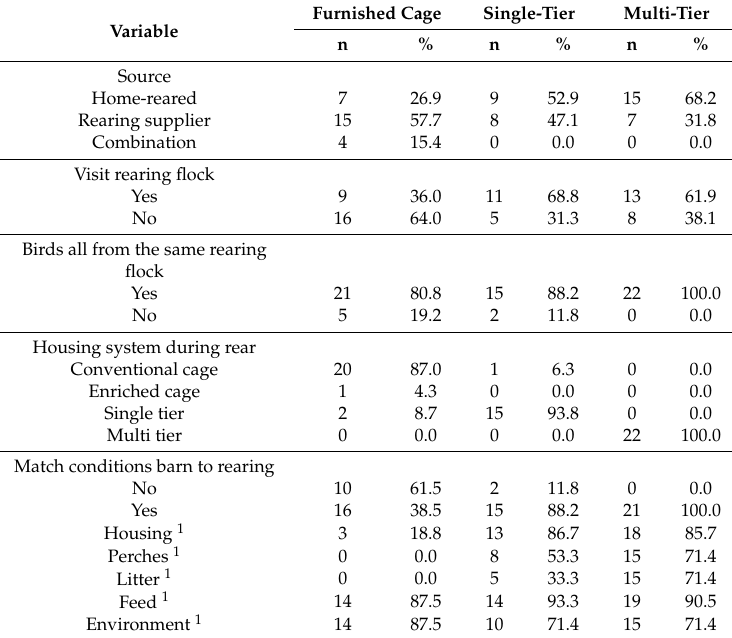
Table 7. Description of flock rearing and placement practices for 65 laying hen flocks placed between October 2016 and December 2017 according to housing system (furnished cage n = 26, single-tier n = 17, multi-tier n = 22) in